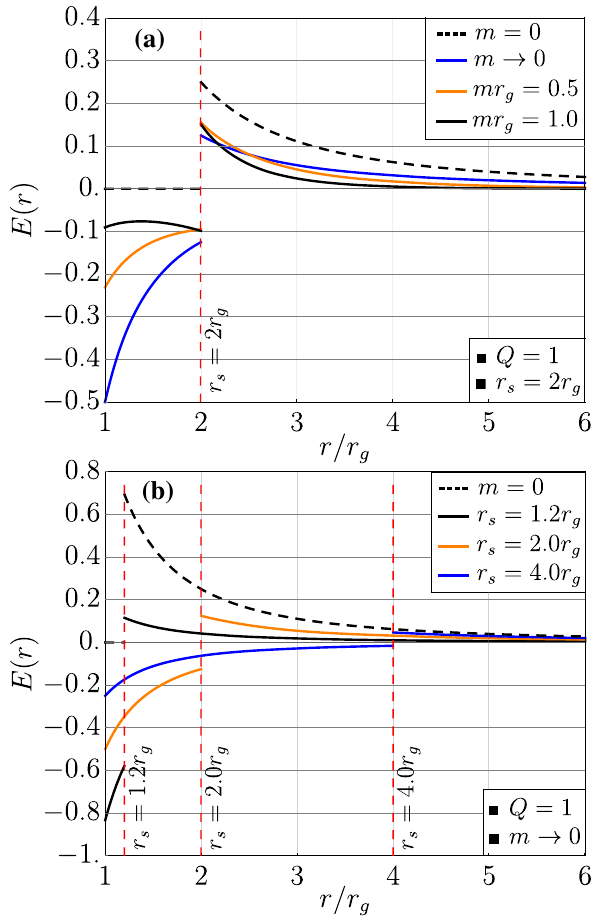
Fig. 1 Thestrength E = ∂ r A t (inSchwarzschildcoordinates)depend- ing on the mass of the photon ( a ) and the position of the charged shell for the photon with a negligible mass ( b ). The additional parameters are also shown in the figure. Black dashed curves correspond to the Maxwell’s